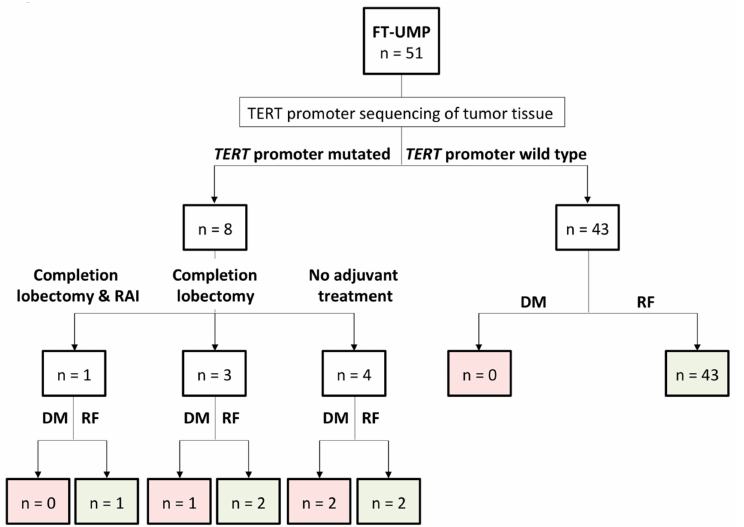
Figure 1. Schematic overview of the clinically recruited follicular tumor of uncertain malignant potential (FT-UMP) cohort with focus on Telomerase reverse transcriptase ( TERT ) promoter genotypes and patient outcome. Of the 51 clinically screened tumors, eight were found to carry a TERT promoter mutation, whereas the remaining 43 cases were wild type, of which two cases were lost to follow-up. While no recurrences are yet recorded among the non-mutated FT-UMP cases, three recurrences (occurrence of distant metastases) were noted among the mutated FT-UMP patients, all recorded in patients who did not receive adjuvant radioiodine therapy. DM, distant metastases; RF,